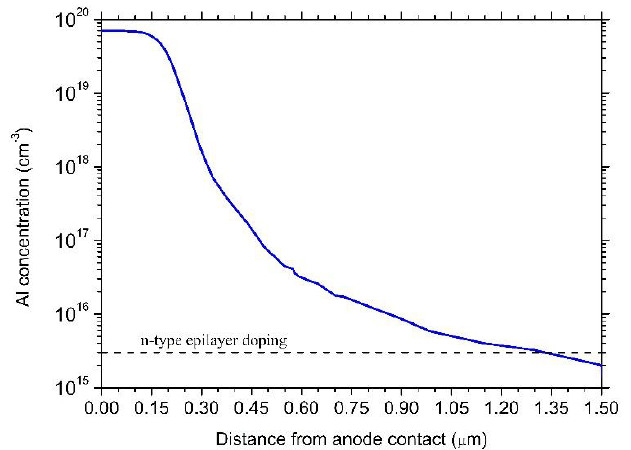
Figure 2. Secondary ion mass spectrometry profile of the Al − implanted doping concentration.